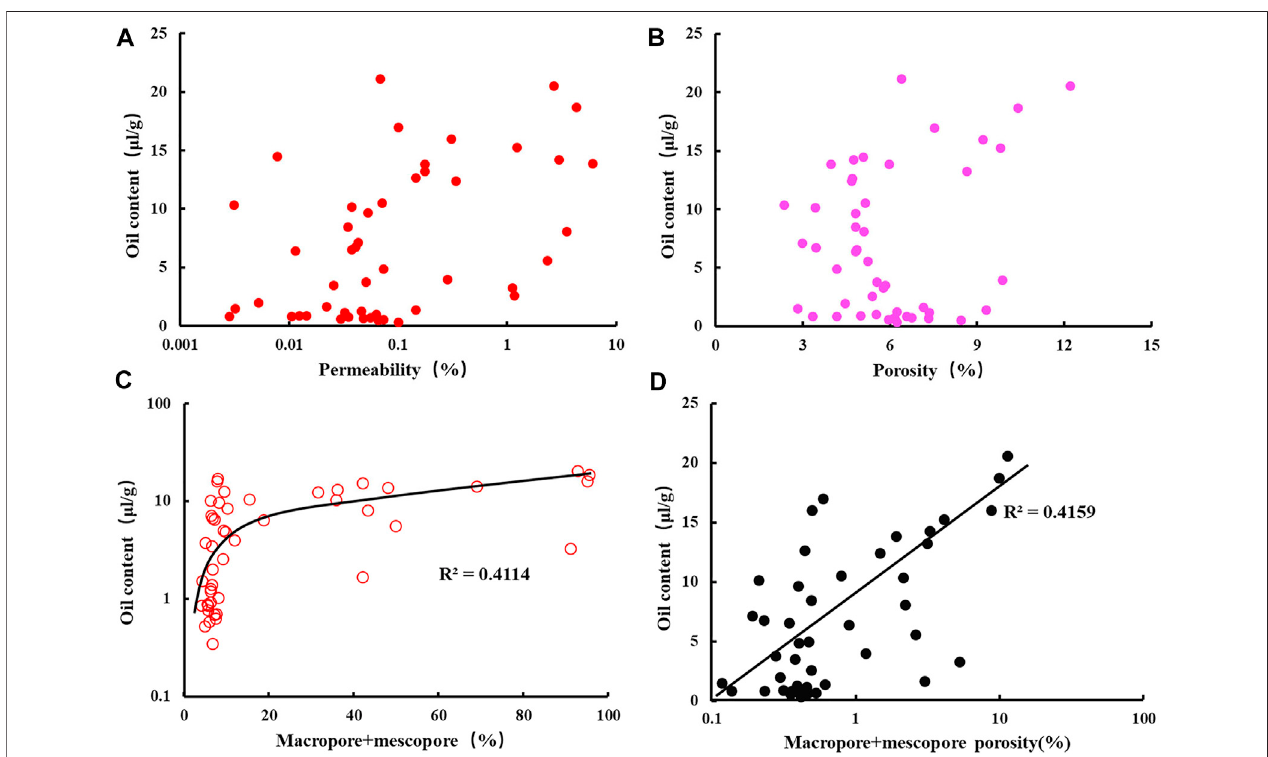
FIGURE 12 | (A) The relationship between permeability and oil content; (B) The relationship between porosity and oil content; (C) The relationship between macropore + mesopore proportion and oil content; and (D) The relationship between macropore + mesopore porosity and oil content.